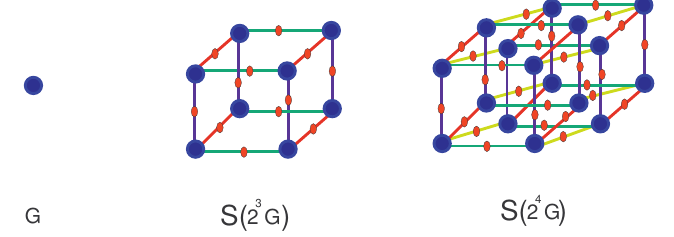
Figure 4. S ( η ζ Γ ) for ζ = 2,3 when Γ is a single vertex